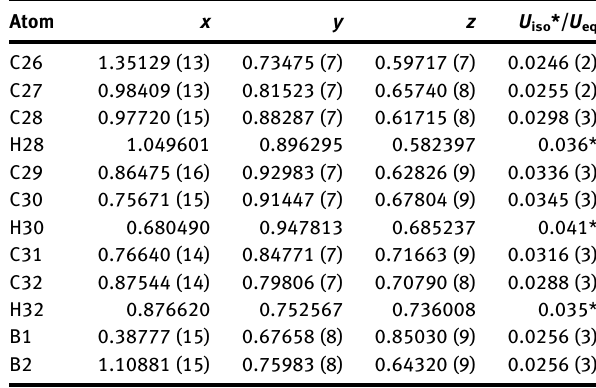
Table  : Fractional atomic coordinates and isotropic or equivalent isotropic displacement parameters (Å 